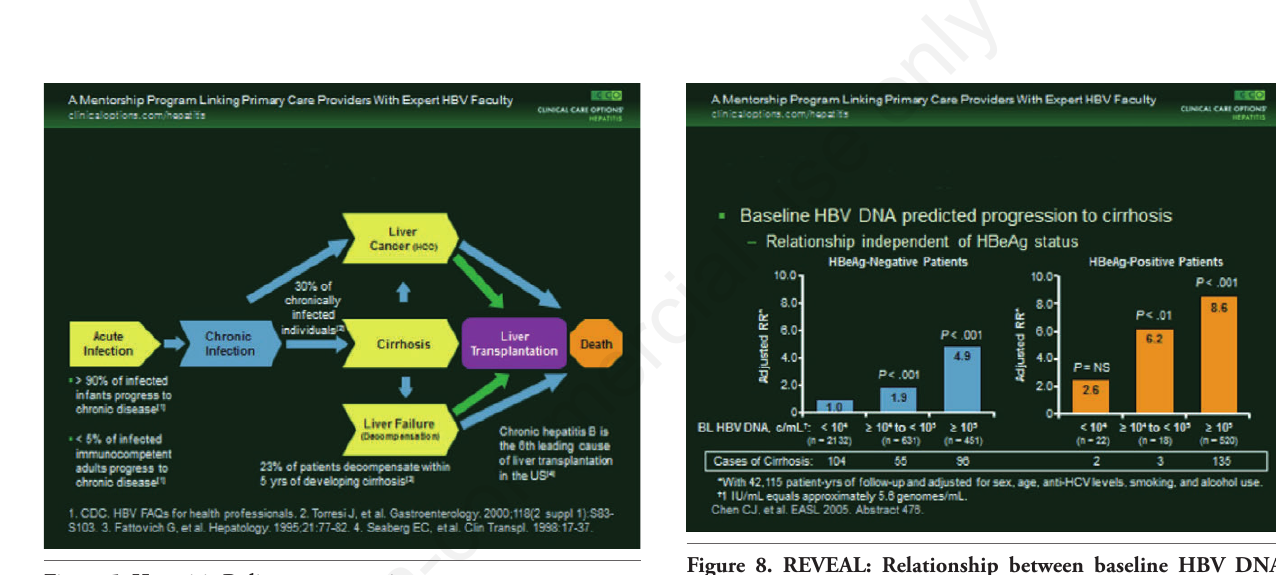
Figure 5. Hepatitis B disease progression.